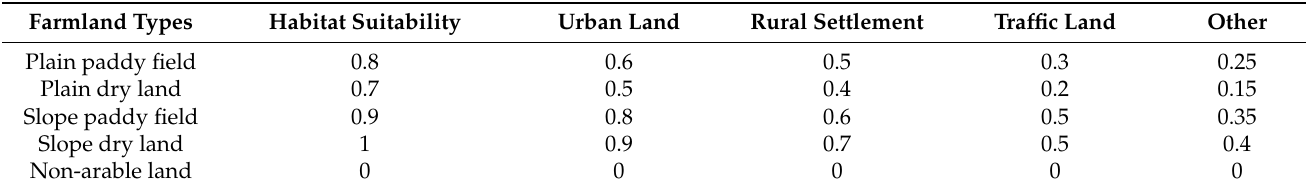
Table A2. The sensitivity of different farmland types to threat sources.